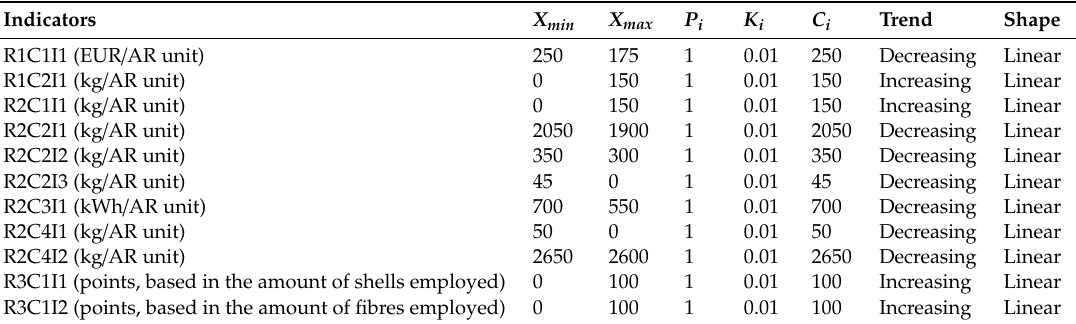
Table 9. Parameters for the value functions.